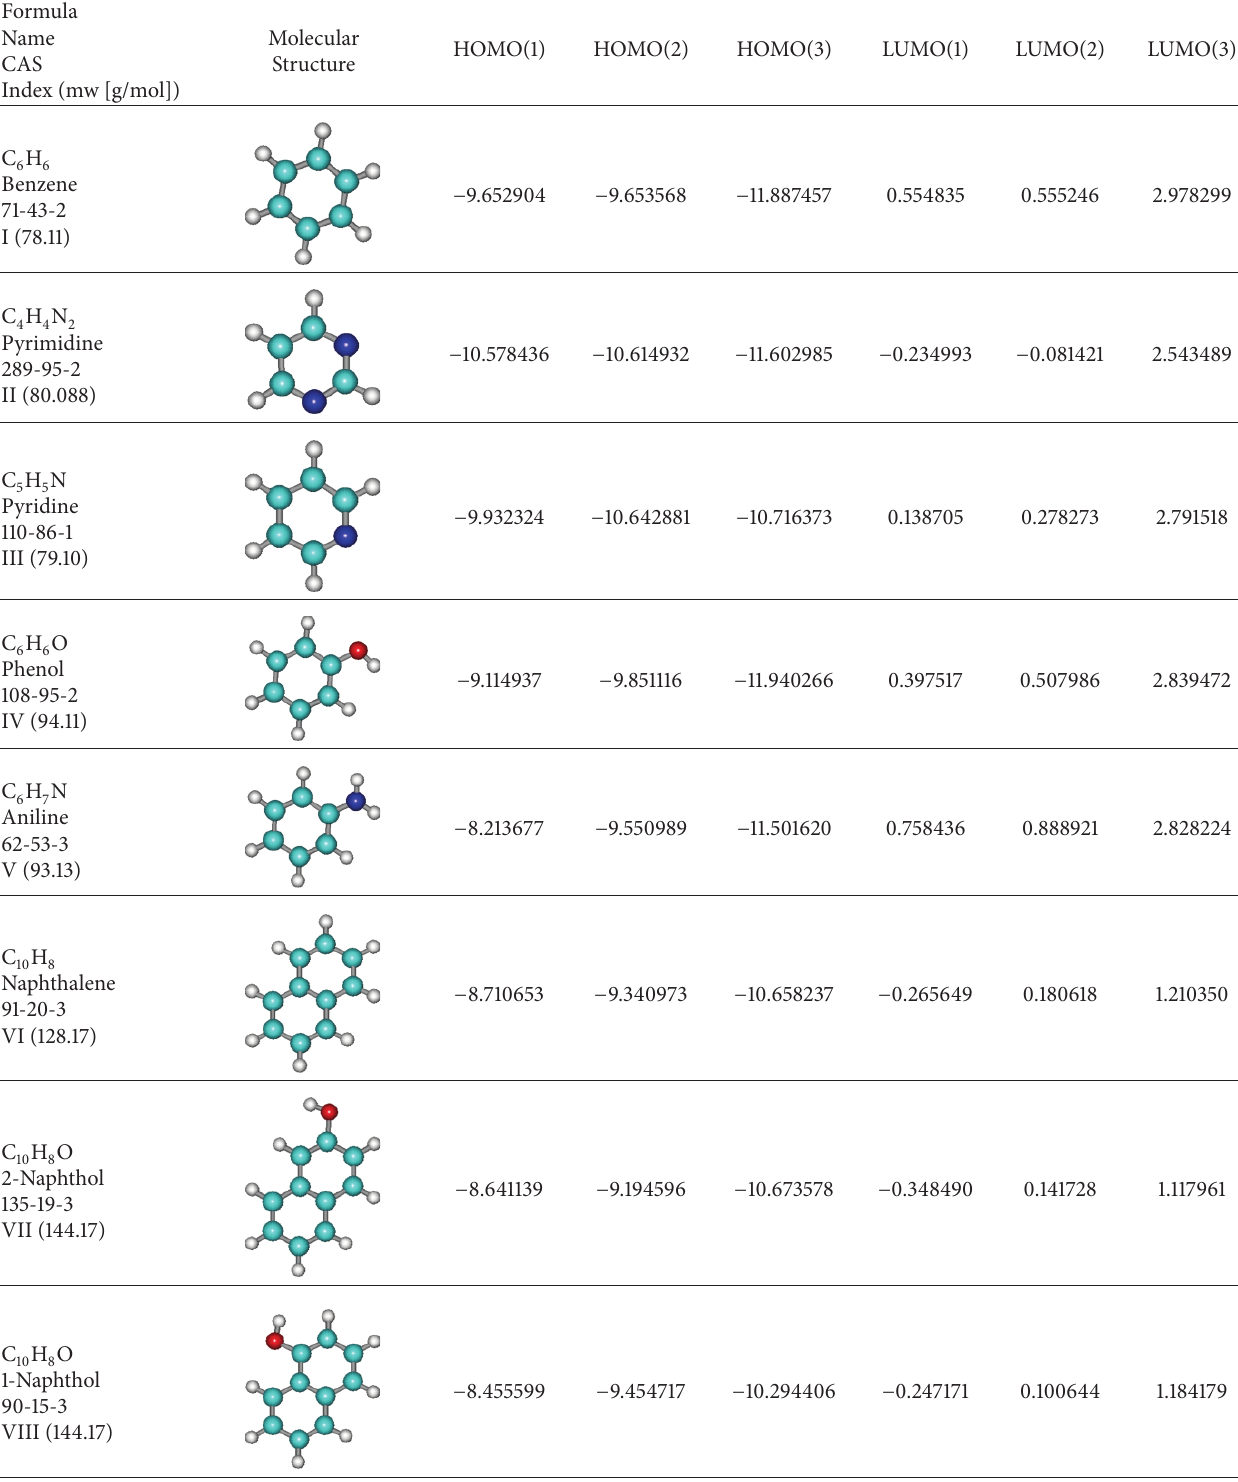
Table 2: Molecular structures of paradigmatic aromatic hydrocarbons [66], ordered downwards according with their H¨uckel first-order HOMO-LUMO gap [69], along their first three highest occupied (HOMOs) and lowest unoccupied (LUMOs) (in electron-volts (eV)) computationally recorded levels within semiempirical AM1 method